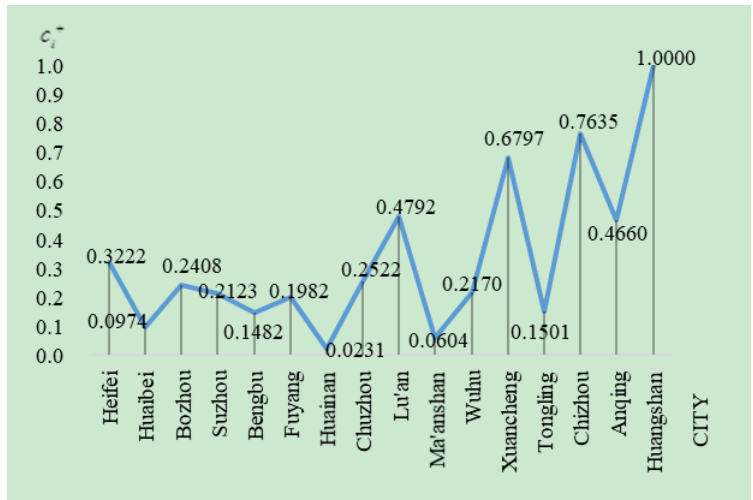
Figure 6. The comparison of ecological sustainability of cities in Anhui province.